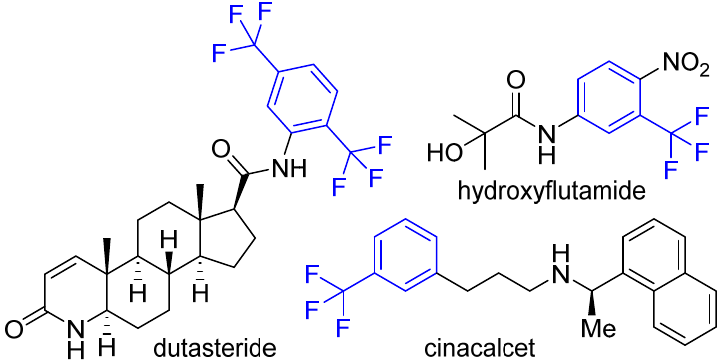
Figure 1. Representative examples of trifluoromethyl phenyl-containing approved drugs.